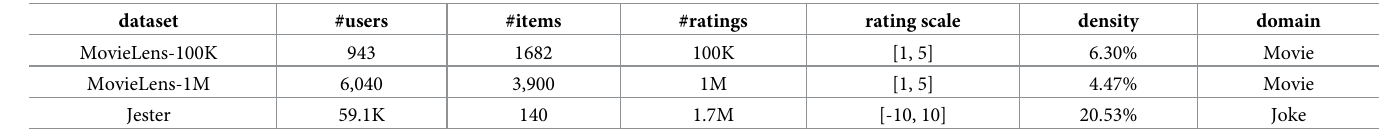
Table 1. Dataset